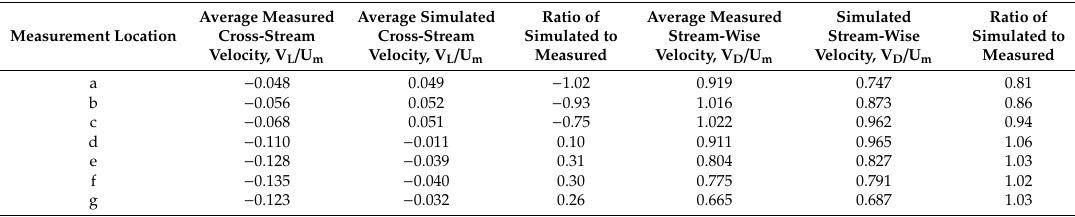
Table A6. Summary comparison of simulated and measured velocities at Cross-section 10 using the finest model mesh size (492 × 42 × 32).